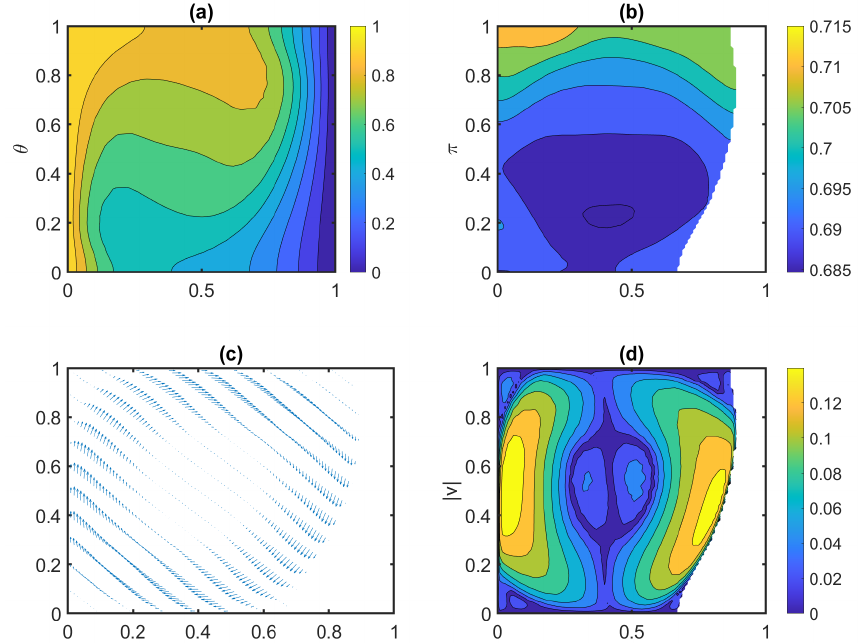
Figure 10. Final condition of PCM cell: ( a ) contours of dimensionless temperature, ( b ) contours of dimensionless pressure, ( c ) velocity vector, ( d ) contours of velocity